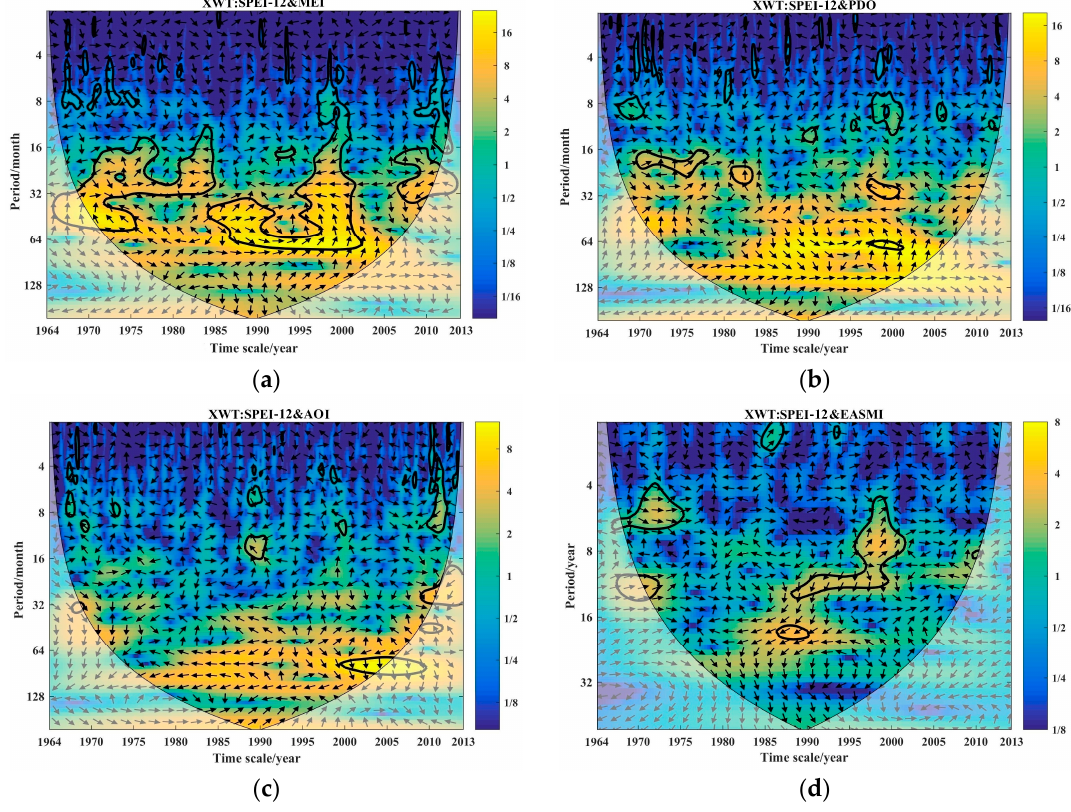
Figure 7. Cross wavelet transform of SPEI ‐ 12 and the MEI ( a ); SPEI ‐ 12 and PDO ( b ); SPEI ‐ 12 and the AOI ( c ); SPEI ‐ 12 and the EASMI ( d ).